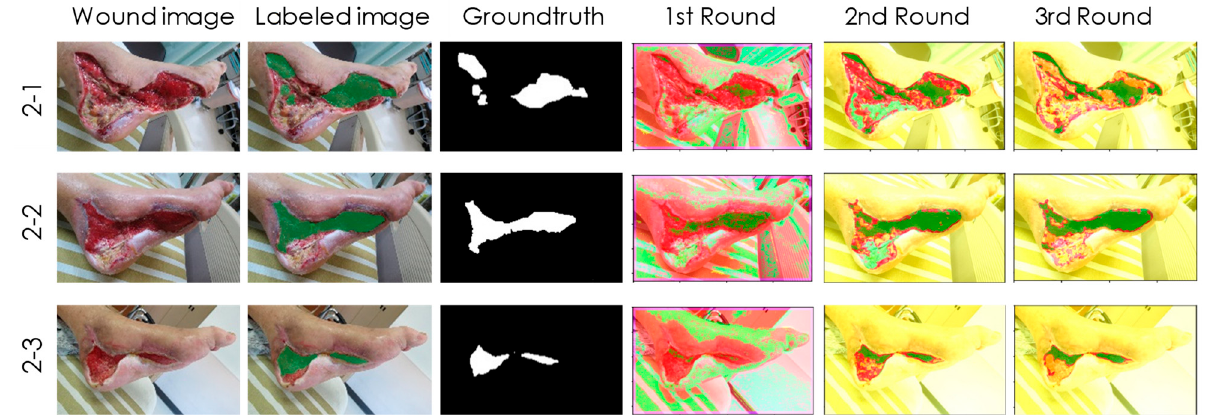
Figure 4. Case 2 of a 68-year-old male patient with poor DM control. The healing process was also accurately traced by our granulation detection model. However, the wound area near the heel was incorrectly classified from class 2 (non-granulation tissues) to class 3 (non-wound areas) after the third training session. This situation did not affect our detection for class 1 (granulation tissues).